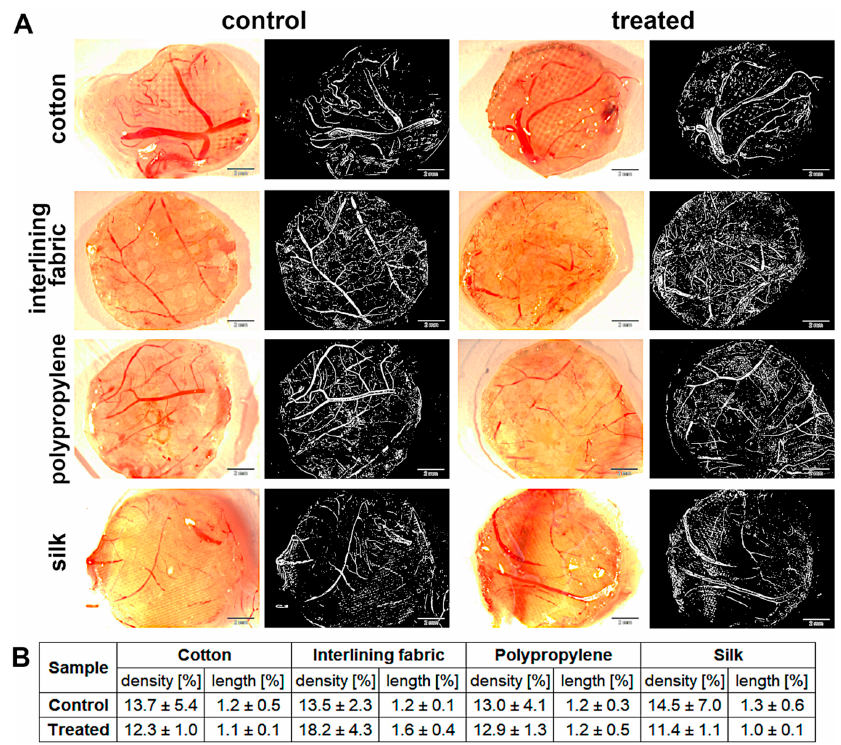
Figure 7. Angiogenesis analysis measured using CAM model: ( A ) measurements under stereomi- croscope and the same measurements as binary images (sample pictures), respectively; ( B ) per- centage of density and length of blood vessels. There were no significant differences between groups ( p -value ≤ 0.05).